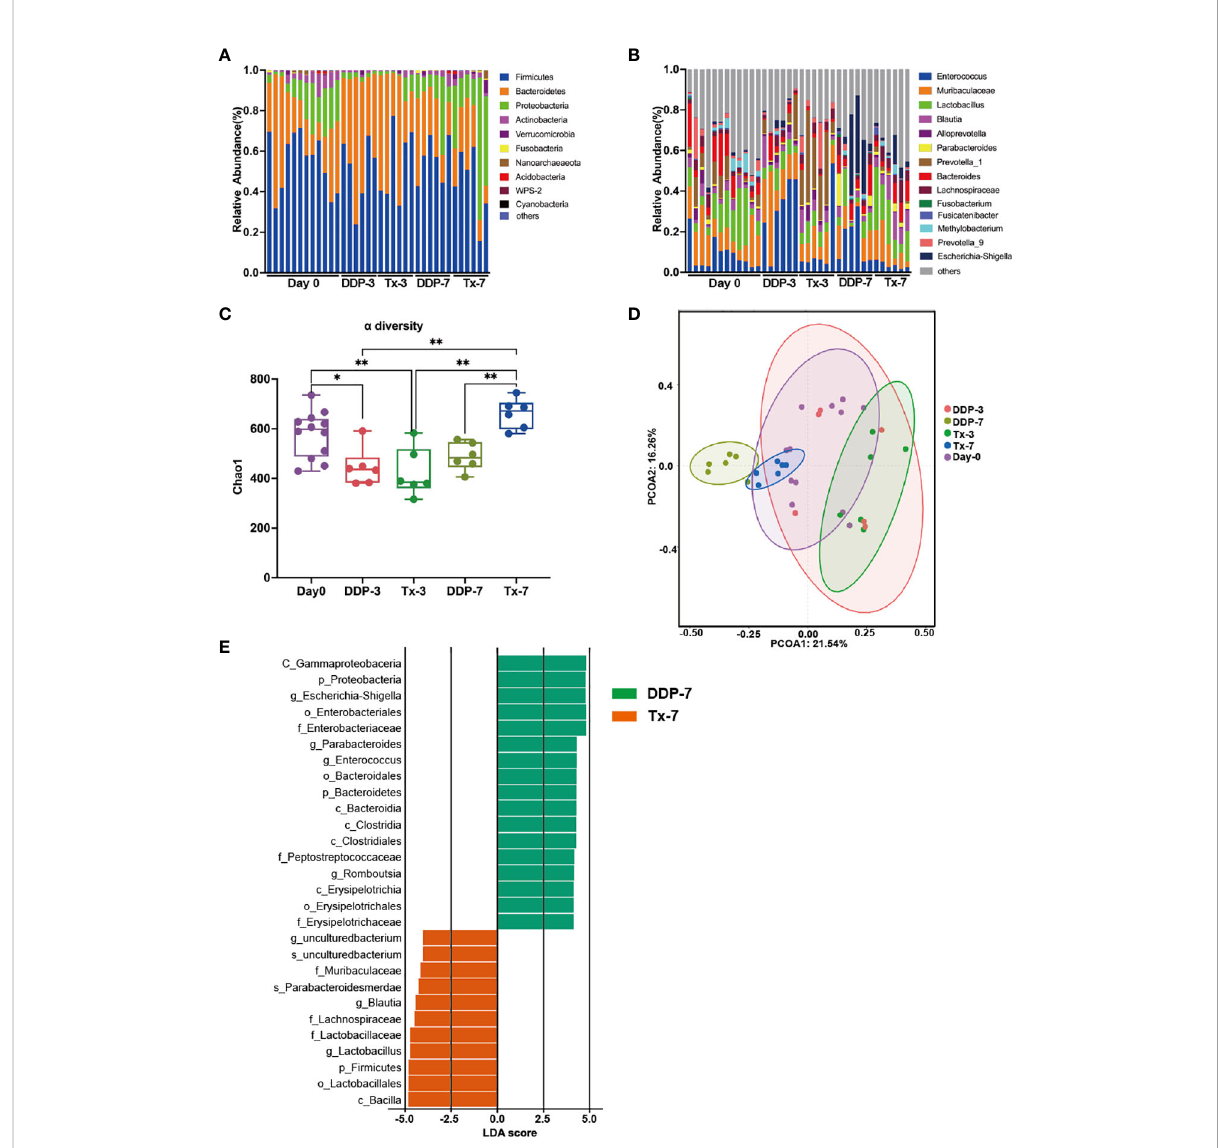
FIGURE 2 Effects of LJAW on the Gut Microbiome in Cisplatin-induced Rat-Pica Model. (A) Stacked bar plot of common bacterial taxa (>0.1% abundance) at the phylum level for fecal samples(Day0, n = 12; DDP-3, n = 6; Tx-3, n = 6; DDP-7, n=6; Tx-7, n=6) by 16S rRNA sequencing. (B) Stacked bar plot of common bacterial taxa (the top 14) at the genera level for fecal samples(Day0, n=12; DDP-3, n = 6; Tx-3, n = 6; DDP-7, n = 6; Tx-7, n = 6). (B) Chao richness index of fecal samples collected before, 3- and 7-days after treatment. (Day0, n = 12; DDP-3, n = 6; Tx-3, n = 6; DDP- 7, n = 6; Tx-7, n = 6. The bars represent the median and the distribution of Chao1 index. p values were determined using Kruskal-Wallis test. * p <0.05, ** p <0.01). (C) Alpha diversity of fecal samples collected before, 3- and 7-days after treatment(Day0, n=12; DDP-3, n=6; Tx-3, n=6; DDP-7, n=6; Tx-7, n=6. * p< 0.05, ** p<0.01). (D) Principal coordinate analysis of fecal samples (n = 30) by response using Weighted UniFrac distances. (E) LDA scores calculated for differentially abundant taxa in the fecal microbiomes of different groups and different time points. Length indicates the effect size associated with a taxon. (LDA score >